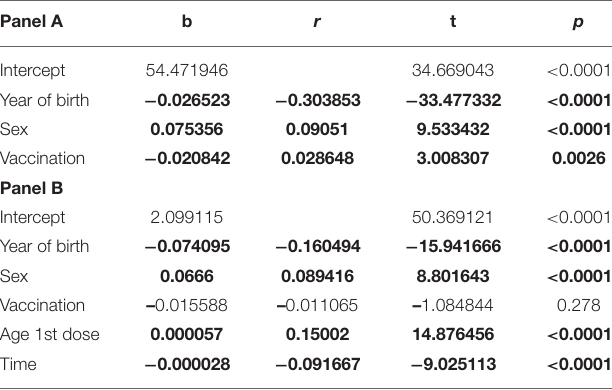
TABLE 3 | Panel A: Multiple linear regression analysis for all students, unvaccinated and vaccinated (once or twice); Panel B: The analysis was performed only for vaccinated subjects (once or